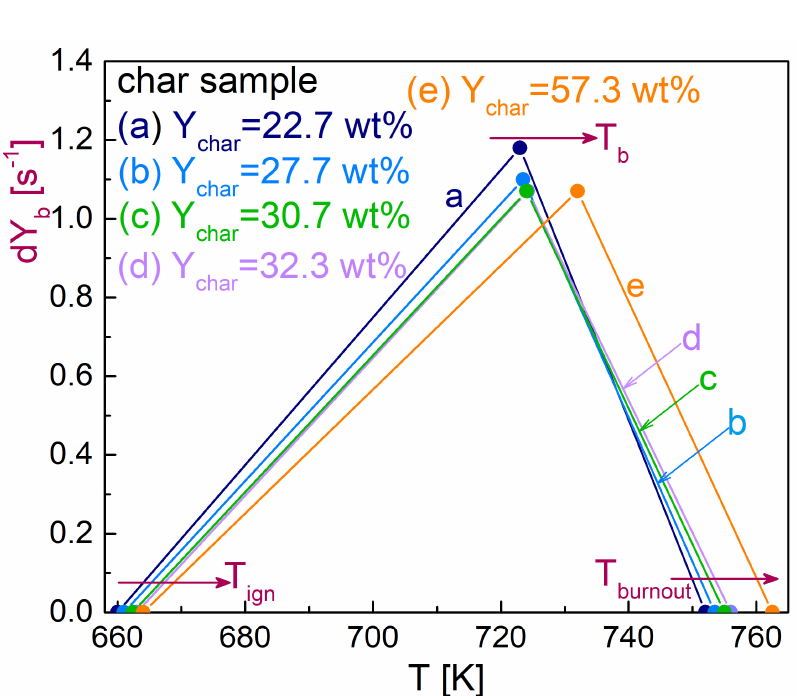
Figure 4. Peak rate versus temperature, using the three characteristic values, T ign , T b and T burnout , for the various char samples (torrefaction conditions as shown in Table 1).